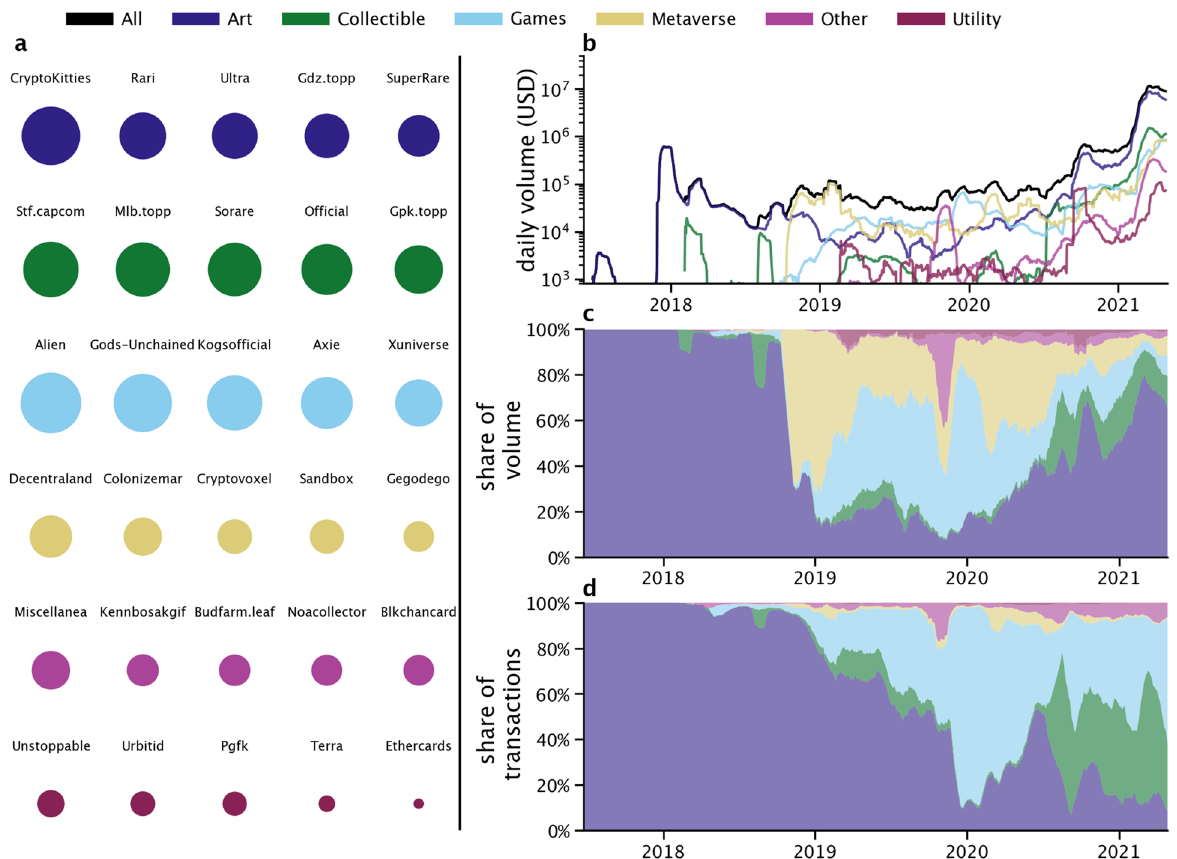
Figure 1. Description of the NFT landscape. ( a ) Top 5 NFTs collections (by number of assets) organized by category. The size of each circle is proportional to the number of assets in each collection. ( b ) Daily volume (in USD) exchanged over time for each category and for all assets (see legend). Days with volume below 1000 USD are not shown. ( c ) Share of volume traded by category. ( d ) Share of transactions by category. Results in these panels are averaged over a rolling window of 30 days.